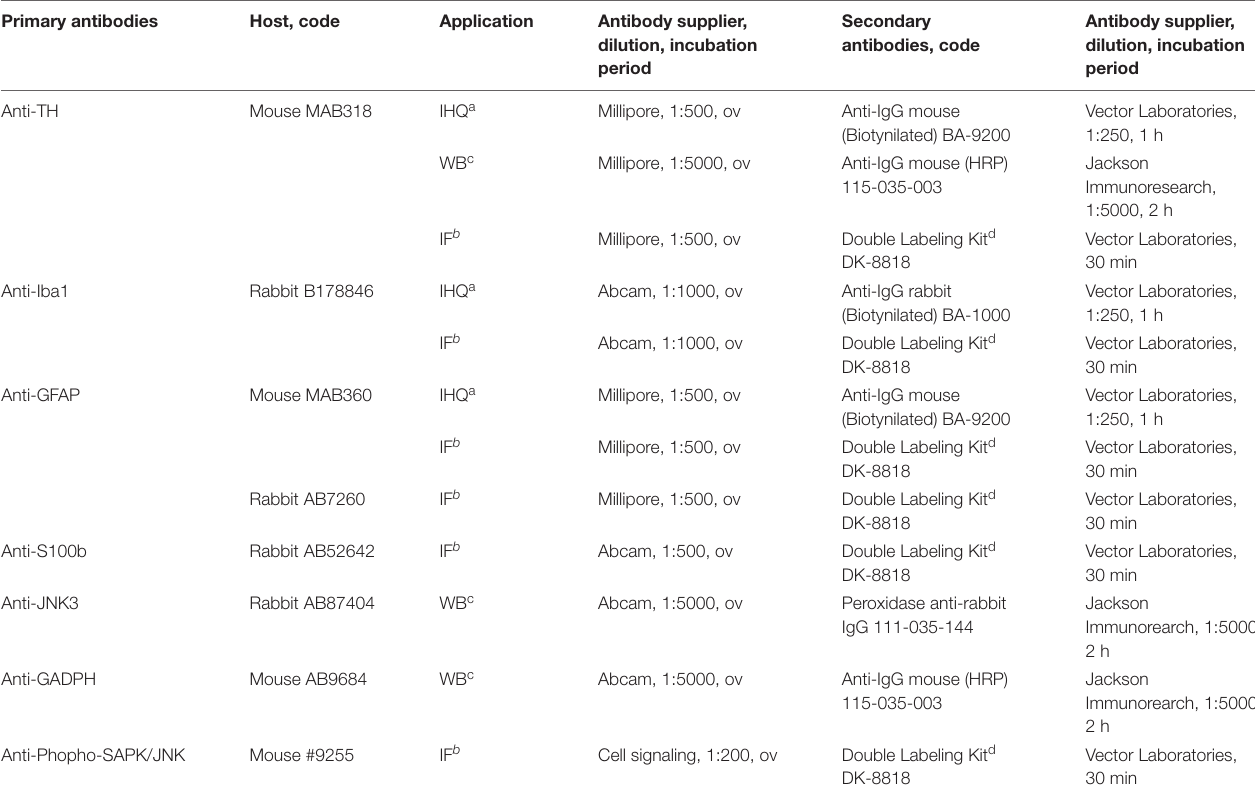
TABLE 1 | Antibodies and protocols for the different